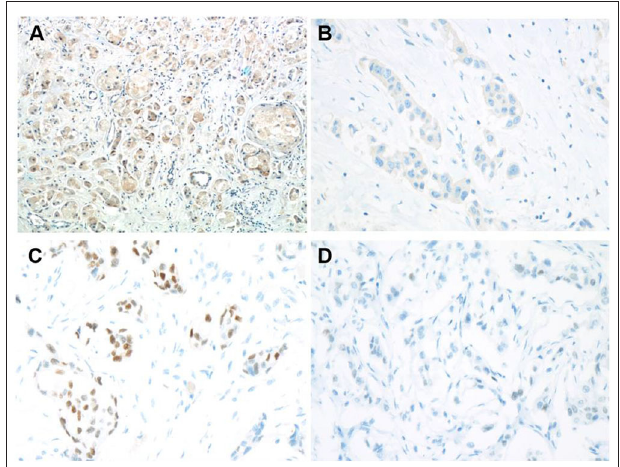
FIGURE 1 | Low expression of ER α and high expression of UGT1A1 in TNBC. To explore the expression of UGT1A1 in TNBC, immunohistochemistry staining was conducted. The results indicated a high expression level of UGT1A1 in tumorous tissues of patients with TNBC (A) . We found that UGT1A1 was present in the nucleus, cytoplasm, and cell surface of para-tumorous tissues at a low expression level (B) . The immunohistochemical staining was used to conduct the determination of ER α expression in TNBC tissues and their paired normal control tissues. Consequently, the positive stains of ER α were observed in the normal mammary gland tissues with the moderate level (C) . However, in TNBC tissues, the low expression of ER α was visible in endothelium (D) .